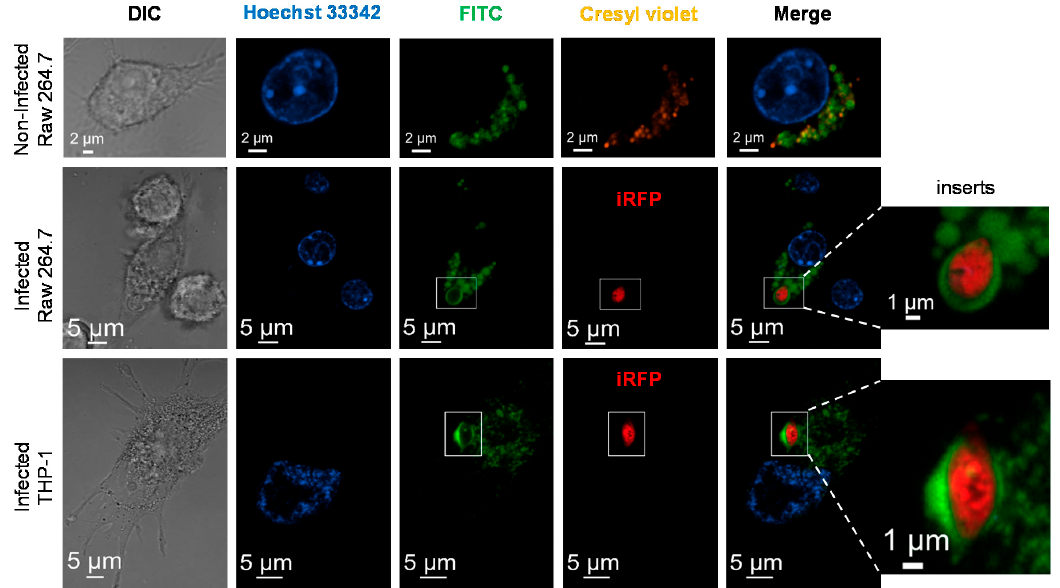
Figure 5. Mannosylated nanocarriers reach the acidic compartments of macrophages and colocalize with L. infantum parasites in phagolysosomes. ( top ) Confocal micrographs of uninfected RAW 264.7 macrophages treated for 24 h with PG–PEG–Mann5–FITC, stained with Hoechst 34580 and cresyl violet and visualized in vivo; ( middle ) confocal micrographs of L. infantum -infected RAW 264.7 macrophages treated as above; ( bottom ) confocal micrographs of L. infantum -infected THP-1- differentiated macrophages. White scale bars in the bright field microscopy pictures are 5 µm and 1